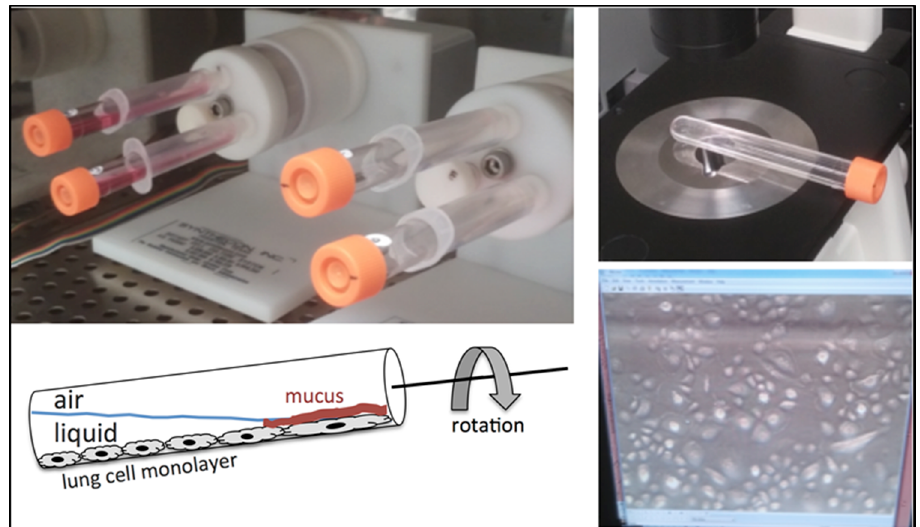
Figure 2. A rotating vessel rotisserie format for the culturing of primary lung epithelial cells of three-dimensional tubular surfaces. By adjusting the angle of the rotation and rotation speed, the cells can be cultured and hydrated but also induced into secreting mucus as they are in contact with liquid only periodically.